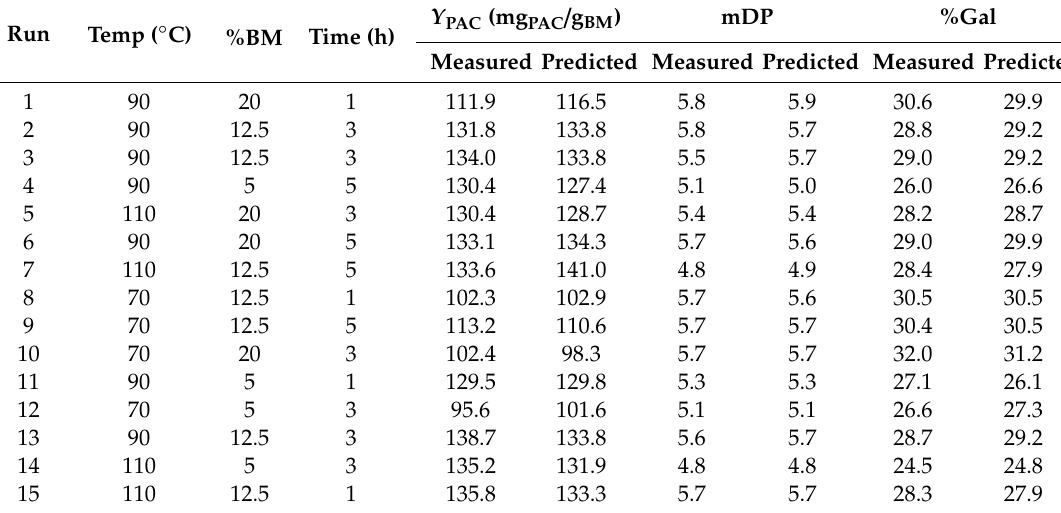
Table A2. Temperature, biomass percentage and time used in the optimization of extraction conditions and respective measured and predicted values of Y PAC , mDP and %Gal.